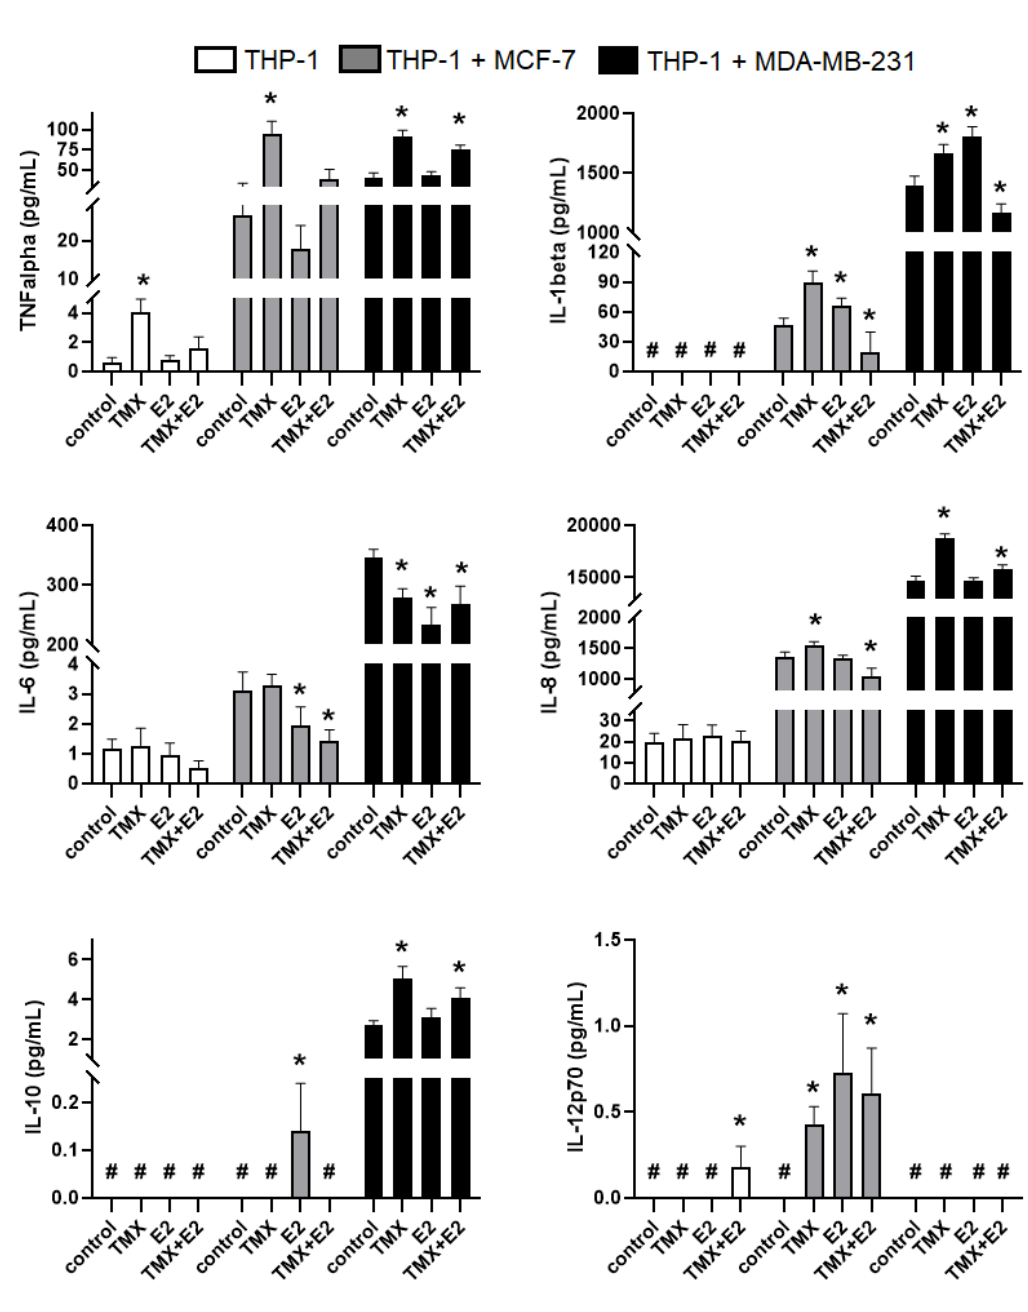
Figure 1. Flow cytometric analysis of monocytic THP-1 cells for the expression of TNF α , IL-1 β , IL-6, IL-8, IL-10 and IL-12p70. Cells were grown in a monoculture or the presence of MCF-7 and MDA-MB-231 cells in a co-culture transwell system, and exposed to TMX (10 µ M) and/or E2 (100 nM) for 24 h. Each column presents the mean concentration from 3 independent experiments. * p < 0.05 vs. the corresponding control group; # concentration < 0.01